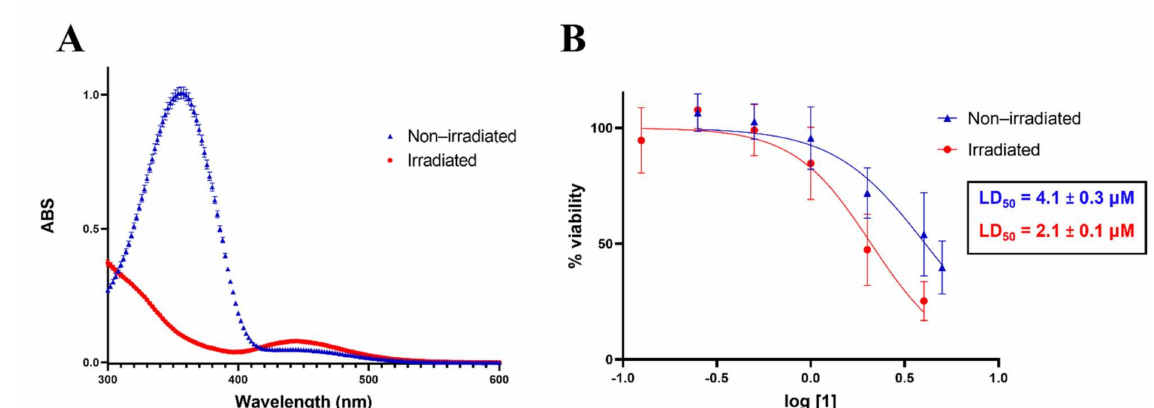
Figure 2. ( A ) UV–Vis absorption spectra of 1 in DMSO before and after irradiation for 10 min with 365 nm light delivered by optical fibre; ( B ) Dose–response curves (0.125–5 µ M) for non-irradiated (blue) and irradiated (red) states of 1 against HCT-116 cells. An MTT assay was used to assess cell viability. The steeper curve of irradiated 1 indicates that it is more active than non-irradiated 1 . Three independent experiments, n =